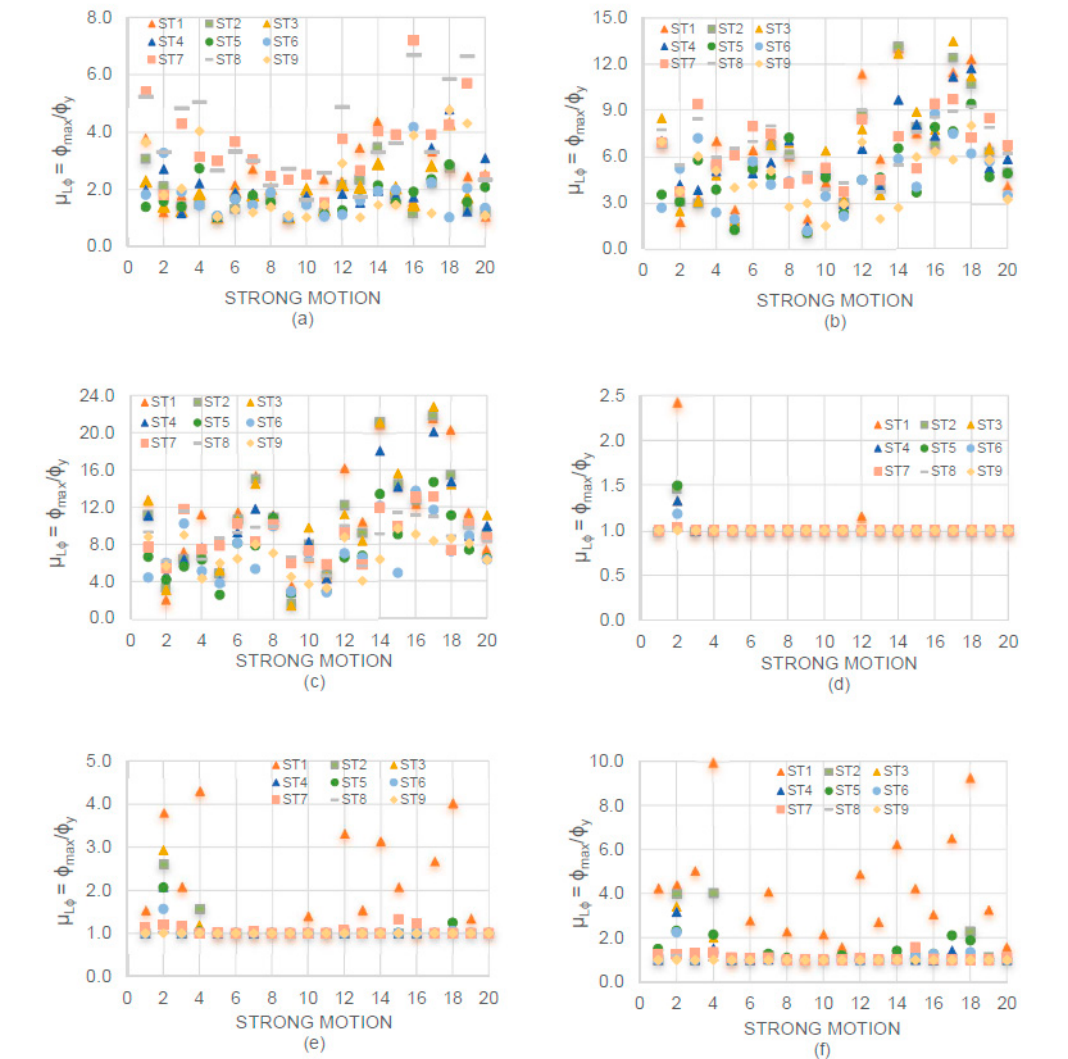
Figure 4. Bending local ductility ( µ L φ ), EW direction, 10-level building; beams: ( a ) S a = 0.2 g, ( b ) S a = 0.6 g, ( c ) S a = 0.8 g; columns: ( d ) S a = 0.2 g, ( e ) S a = 0.6 g, ( f ) S a = 0.8 g.